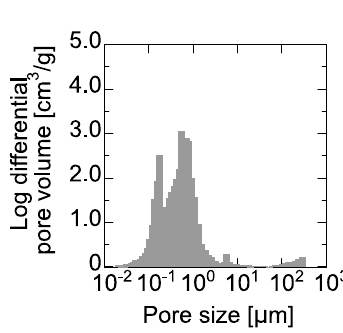
Figure A1. Pore distribution of PE membrane.